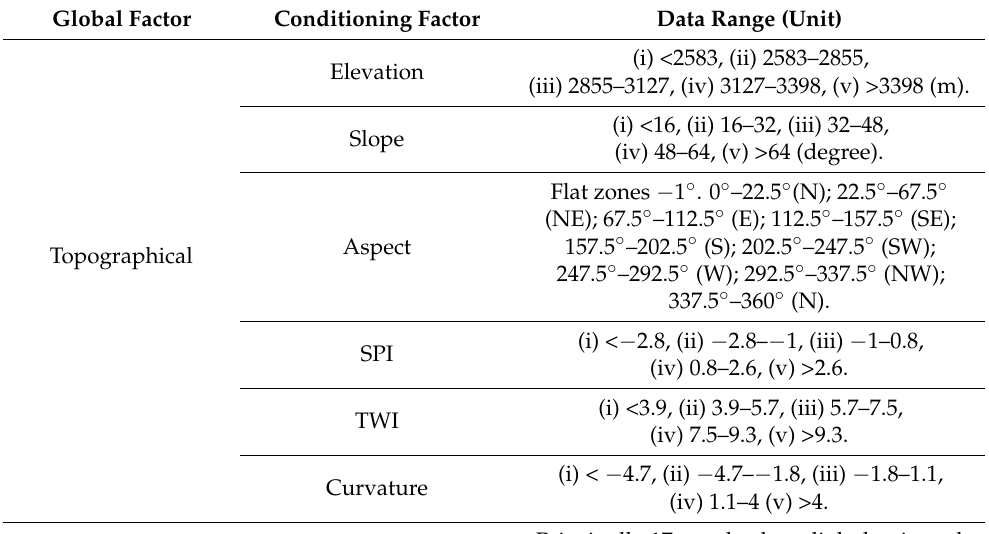
Table 2. Conditioning factors considered in this